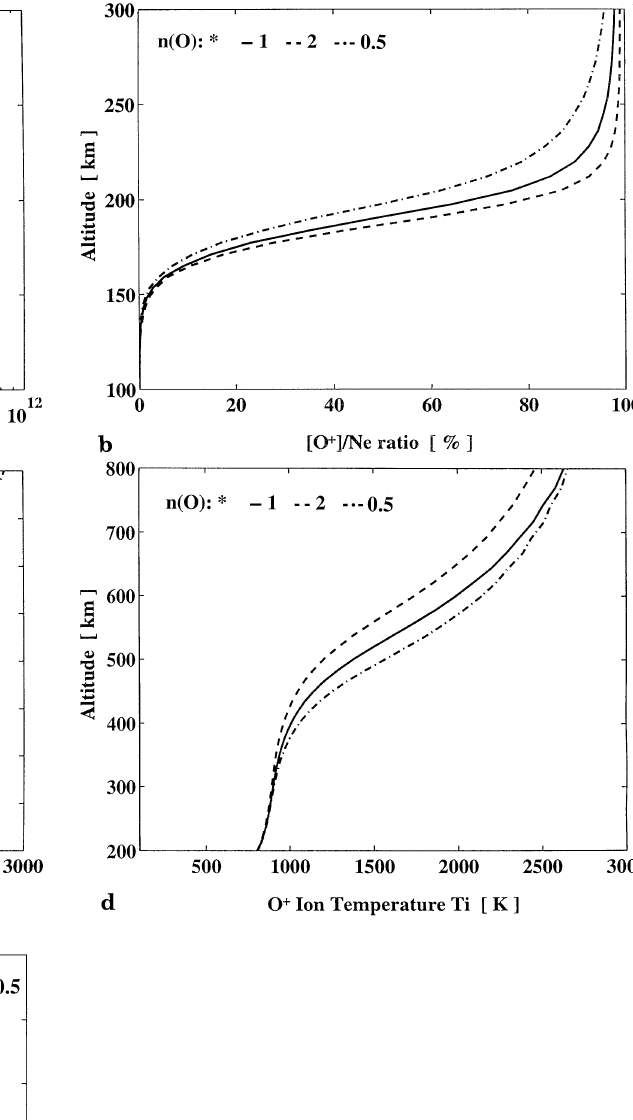
Fig. 7a (cid:177) e. Effect, in the altitude range of interest, of the ato- mic oxygen on the profiles of a electron concentration, b O (cid:96) composition parameter, c electron temperature, d O (cid:96) ion temperature and e O (cid:96) ion-temperature gradient. The full line corresponds to the standard adjustment, the dashed line to atomic oxygen concentration multiplied by 2 and the dot - dashed line to atomic oxygen concentration divided by